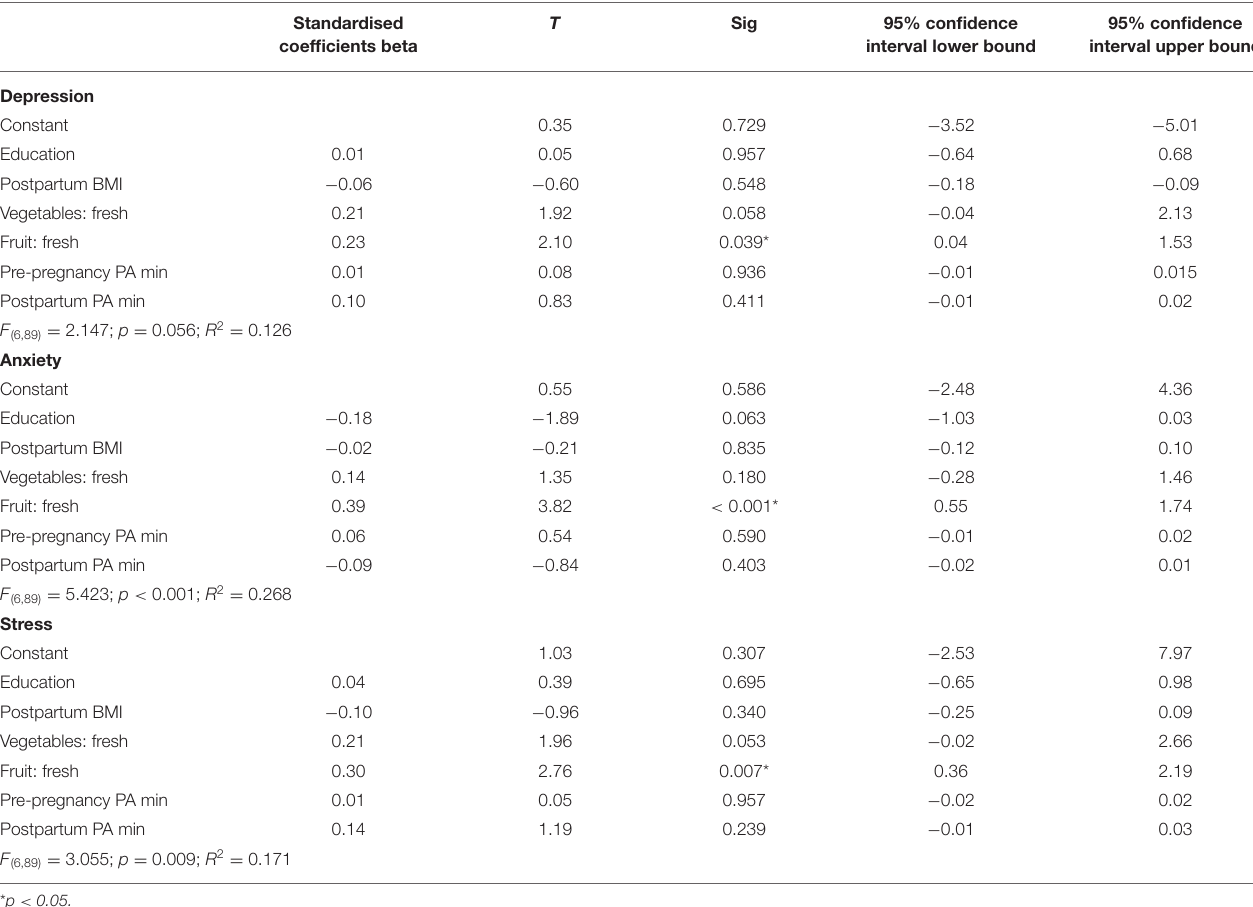
TABLE 3 | Linear regression analysis for mental health scores against education level, post-partum BMI, fresh vegetable and fruit intake, pre-pregnancy physical activity, postpartum physical activity.